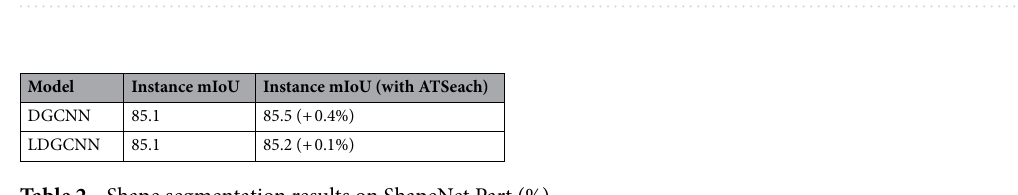
Table 2. Shape segmentation results on ShapeNet Part